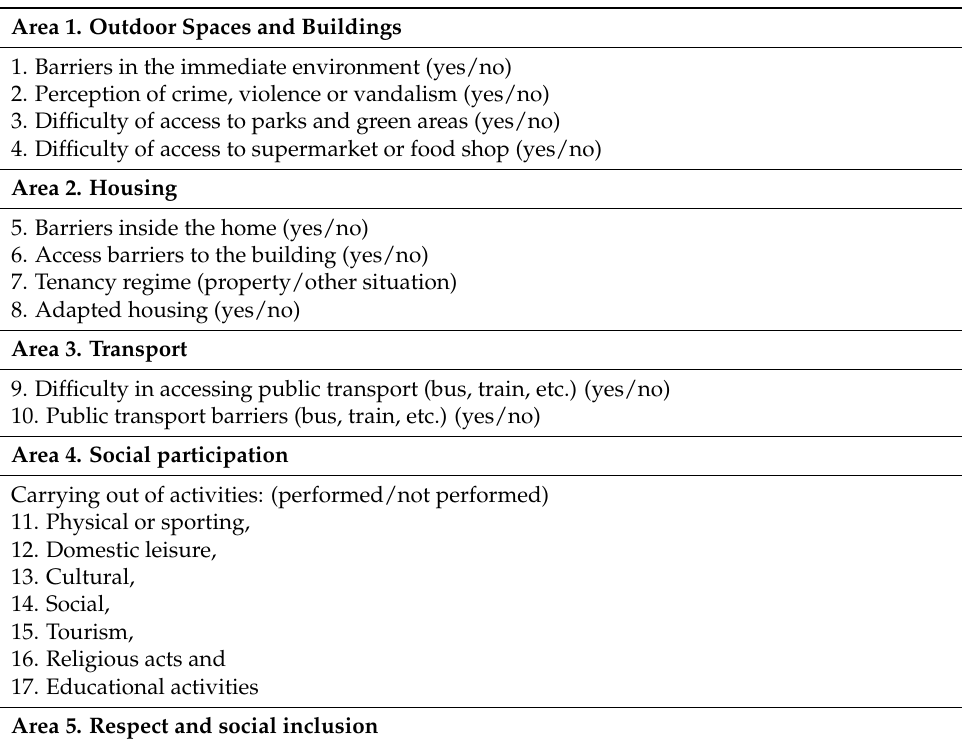
Table 2. Variables selected as components of